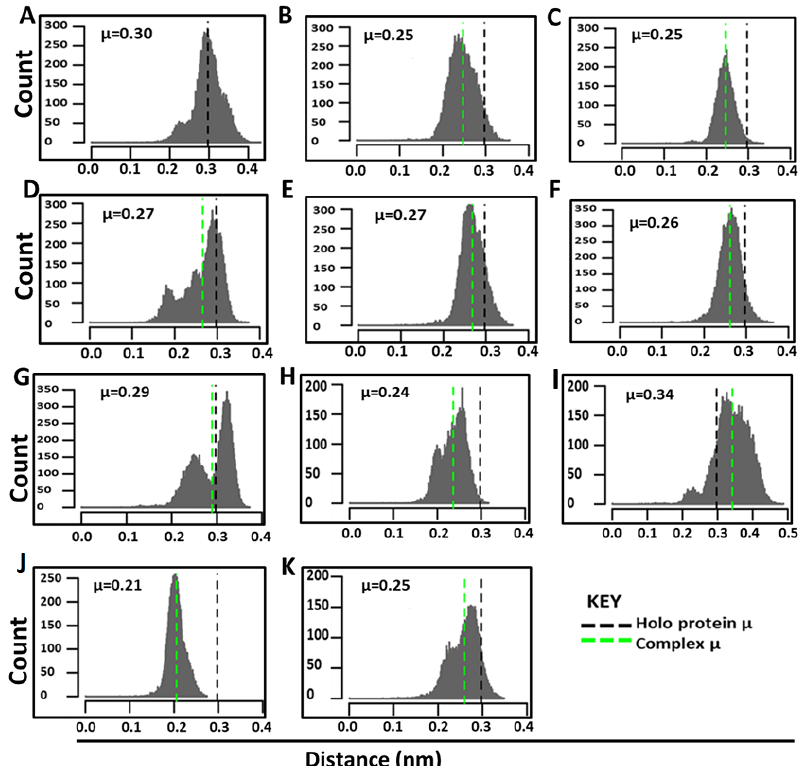
Figure 5. Backbone RMSD distribution plots for PfProRS ligand-bound complexes. Conformational flexibility can be assessed by comparing the backbone RMSD distribution of each ligand-bound complex and the holo protein. Comparison of the mean (µ) of the holo protein (black dashed line) to each ligand complex (green dashed line) demonstrates the shift in conformation distribution of the complexes during the 200 ns MD simulation. σ is the standard deviation. ( A ) Holo system (PfProRS-ADN), ( B ) PfProRS-SANC152 complex, ( C ) PfProRS-SANC235 complex, ( D ) PfProRS-SANC236 complex, ( E ) PfProRS-SANC244 complex, ( F ) PfProRS-SANC318 complex, ( G ) PfProRS-SANC184 complex, ( H ) PfProRS-SANC257 complex, ( I ) PfProRS-SANC264 complex, ( J ) PfProRS-SANC456 complex and ( K ) PfProRS-SANC622 complex .